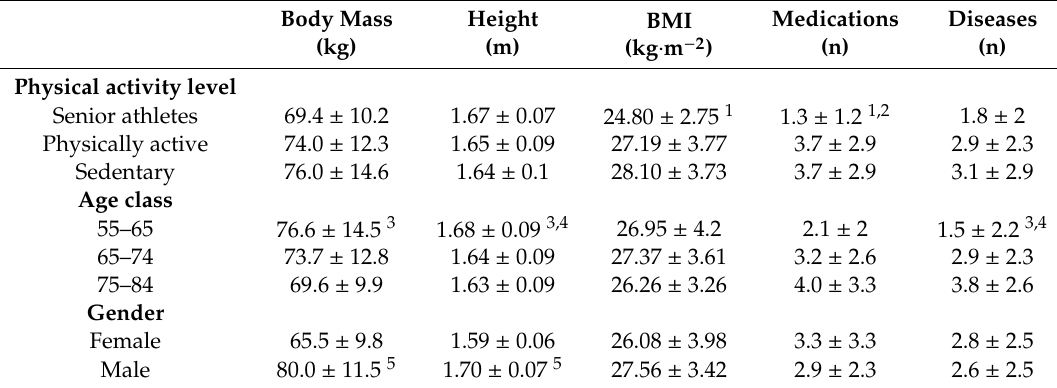
Table 1. Anthropometric characteristics, BMI, number of medications, and diseases (mean ± SD)